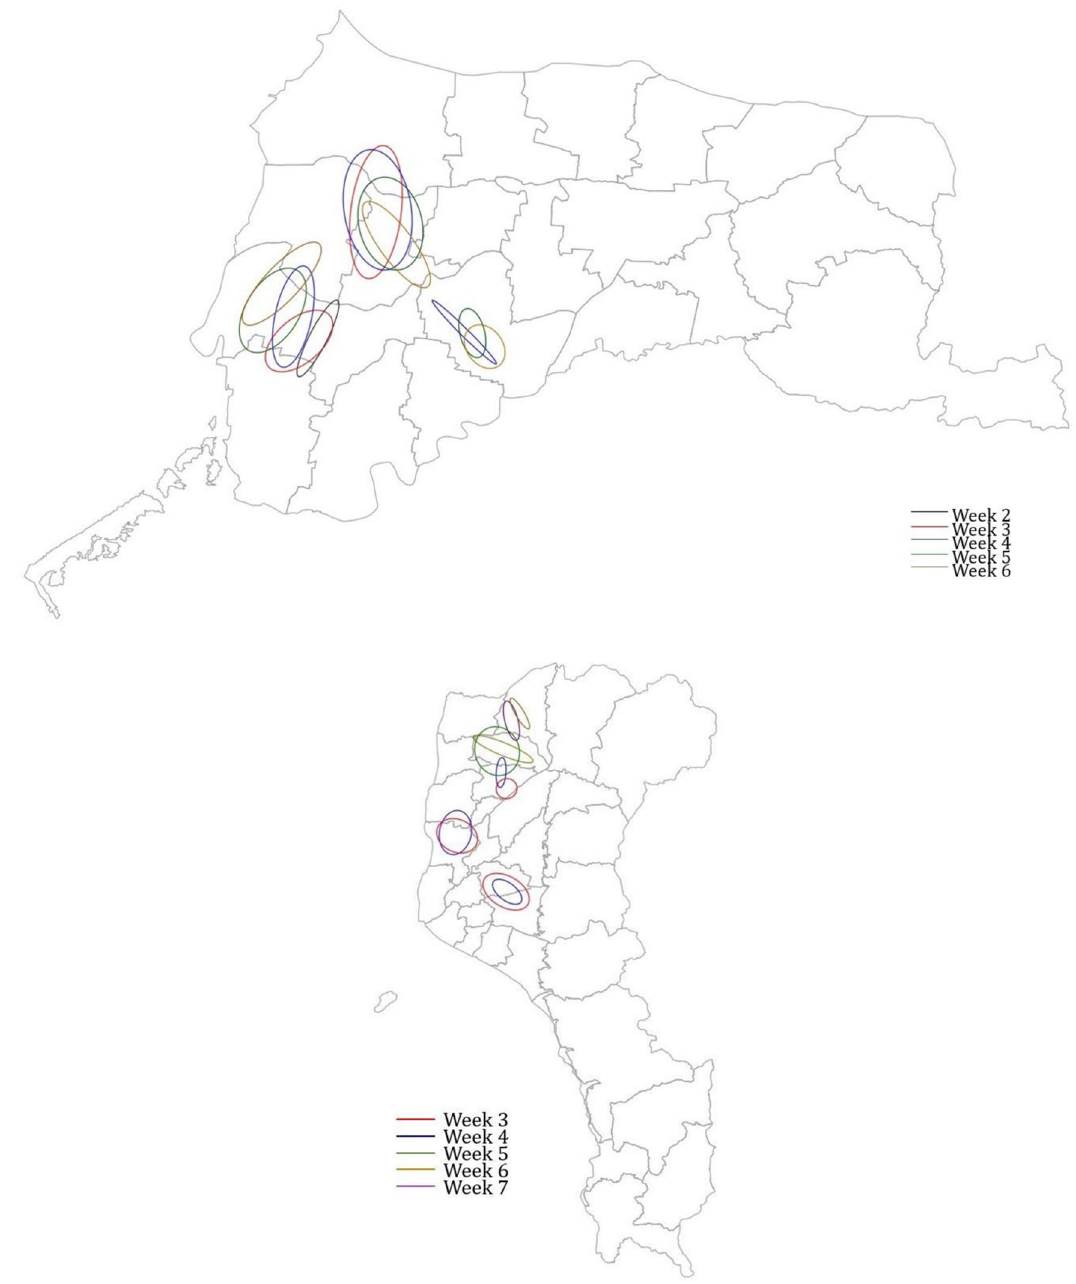
Figure 4. The week-by-week SDEs for individual clusters identified in YL (3 clusters, upper panel) and PT (4 clusters, lower panel)